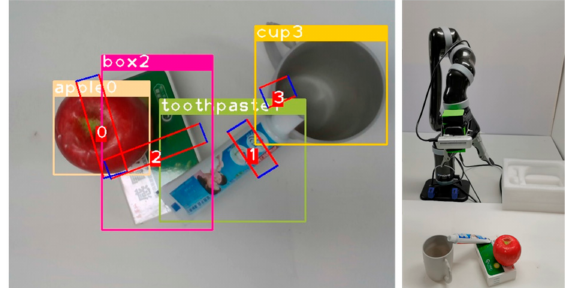
Figure 10. Multi-target grasp detection